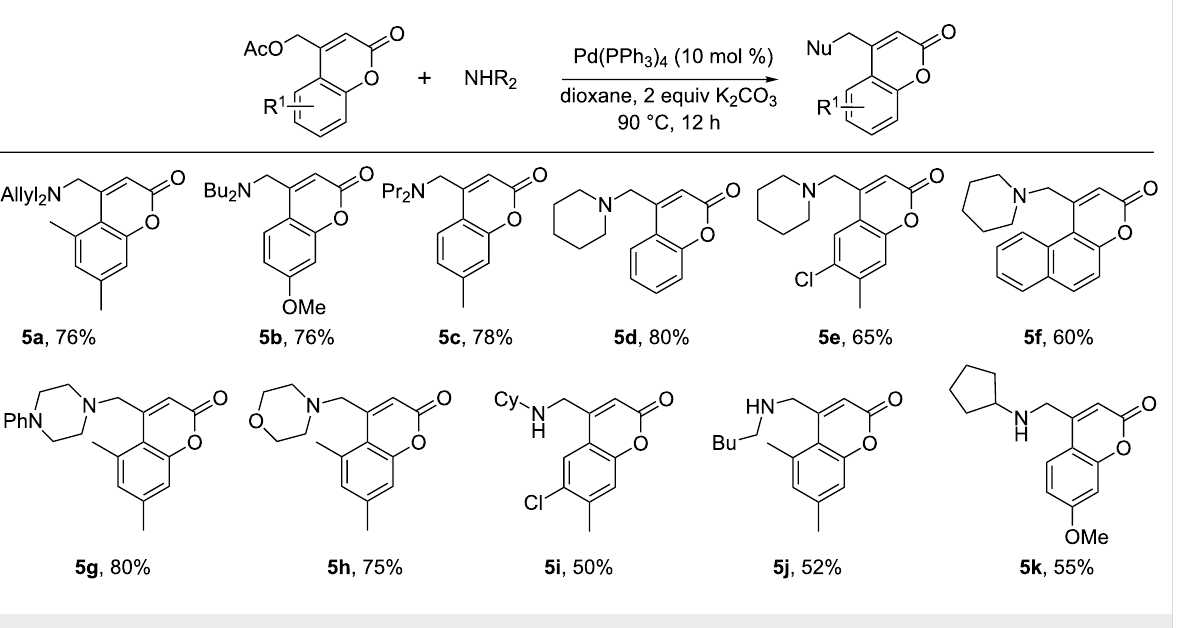
Scheme 6: Scope of the coumarinyl acetate and amine coupling reaction.